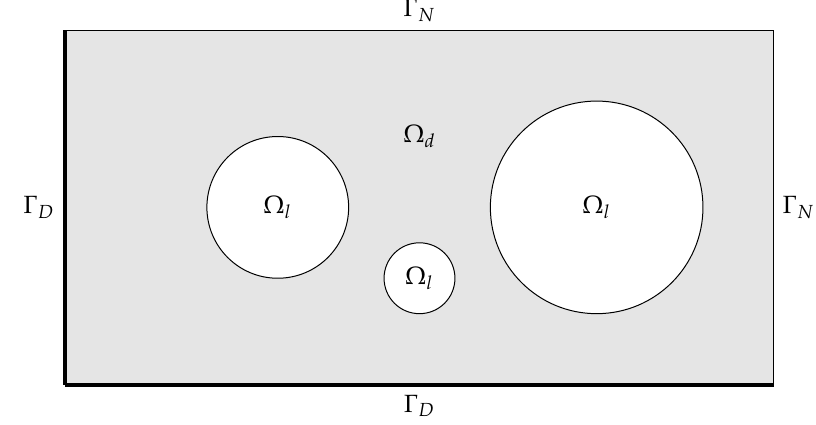
Figure 1. Example geometry and boundary